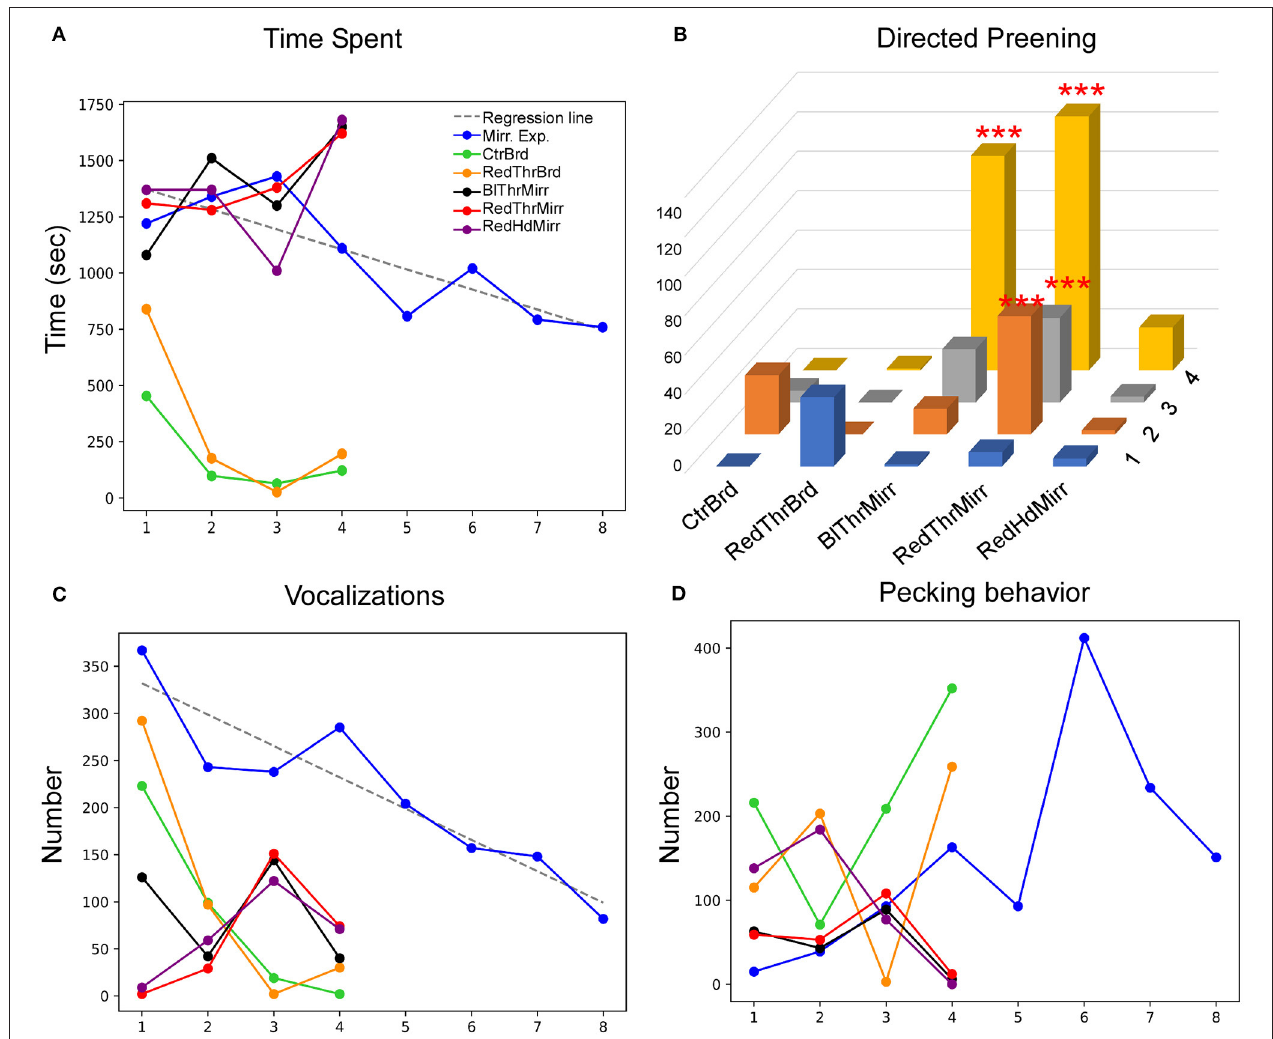
FIGURE 5 | Behavioral response of an adult male zebra finch (Y45) during the MSR test. (A) This bird displayed a significant decrease in the time spent facing the mirror during mirror exposure trials. Additionally, this parameter decreased in conditions when the mirror was replaced with a board of similar dimensions. (B) There was a significant increase in preening on a red mark placed on the neck compared to controls. Furthermore, there was a significant increase in preening in Trial 4 when a black mark was placed on the neck (***; P < 0.001; Fisher’s exact test). (C) There was a significant decrease in vocalization across different trials during the mirror exposure period (indicated by the dotted regression line). Vocalization also decreased in all other conditions (whether in the mirror or board conditions) by Trial 4. (D) There was an increase followed by a decrease in pecking on the mirror during the mirror exposure trials and this trend was seen in all test mirror conditions. However, the reverse trend was observed for the board